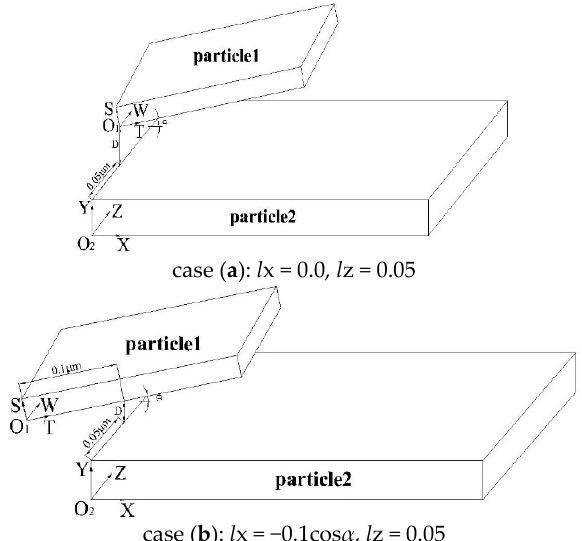
Figure 13. Two specific cases of edge-face contact.